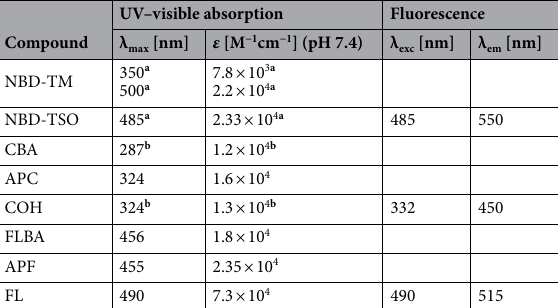
Table 2. Absorption maxima (λ max ), extinction coefficients (ε), fluorescence excitation (λ exc ), and emission (λ em ) maxima for the studied probes and their oxidation products. a Reference 44 ; b Reference